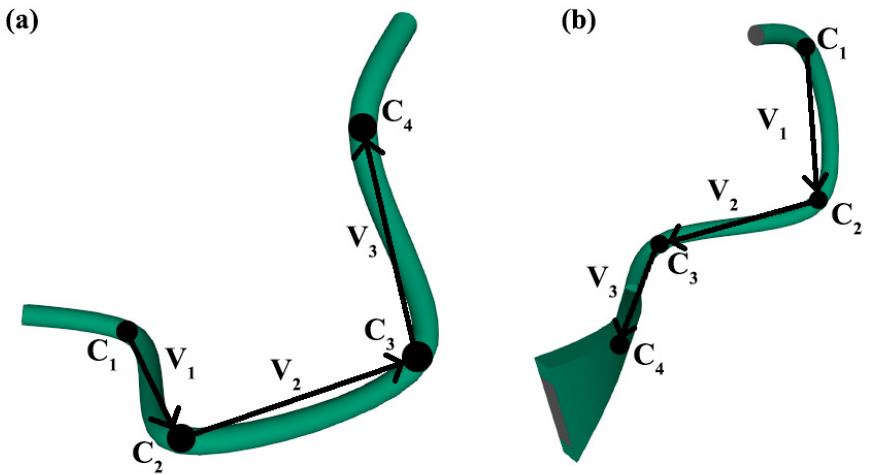
Figure 4. Graphic construction of v i vectors for calculating the mixed vector product, β -turns of the 1A4G protein [99]: ( a ) β -turn, type AG [89]; ( b ) β -turn, type Dd [89] (the studied types of β -turns are discussed in the Results section). C i –atoms of α -carbons, reference points in β -turns.